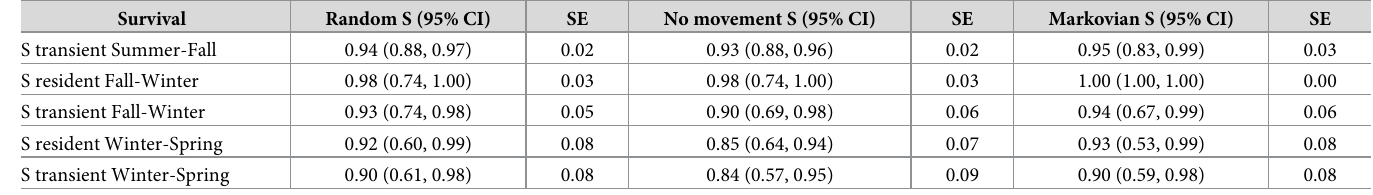
Model-averaged survival estimates are given separately for each of the three temporary emigration models (random, no movement, and Markovian-see methods). Transient refers to survival estimates for the first captures (including transients and residents) while resident refers to survival estimates for all subsequent captures (residents only). SE = standard error.